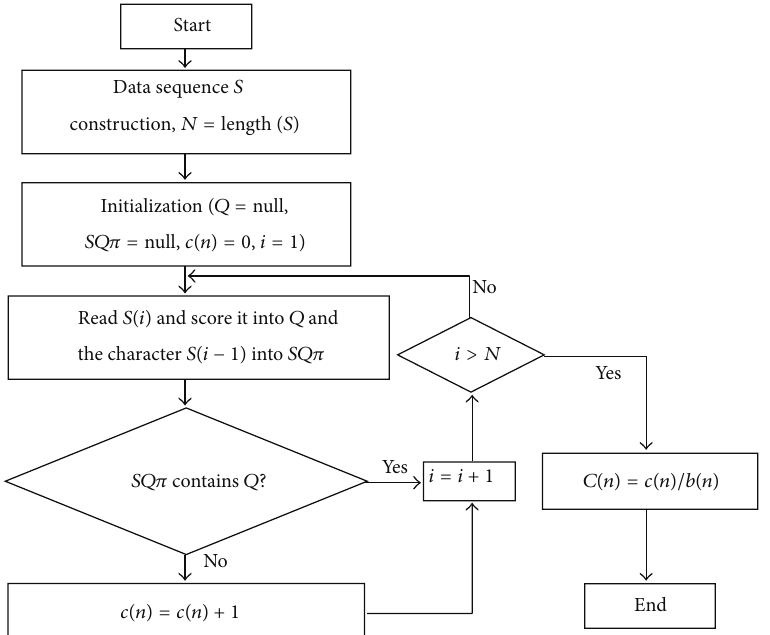
Figure 1: The flow chart of LZC algorithm.